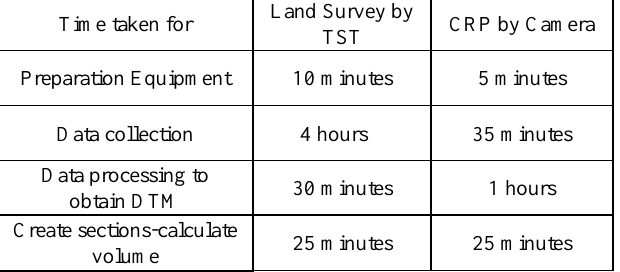
Table 2. Time comparison between both